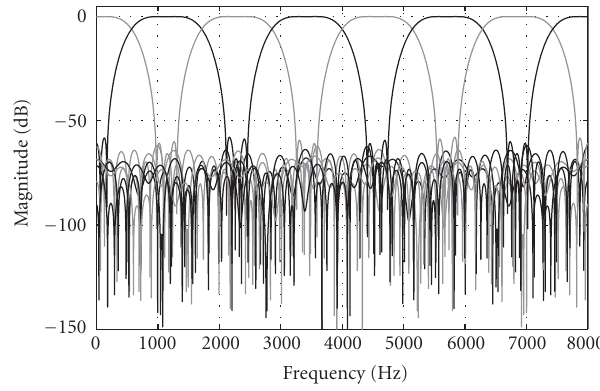
Figure 13: Improved MDLNS filterbank frequency response.